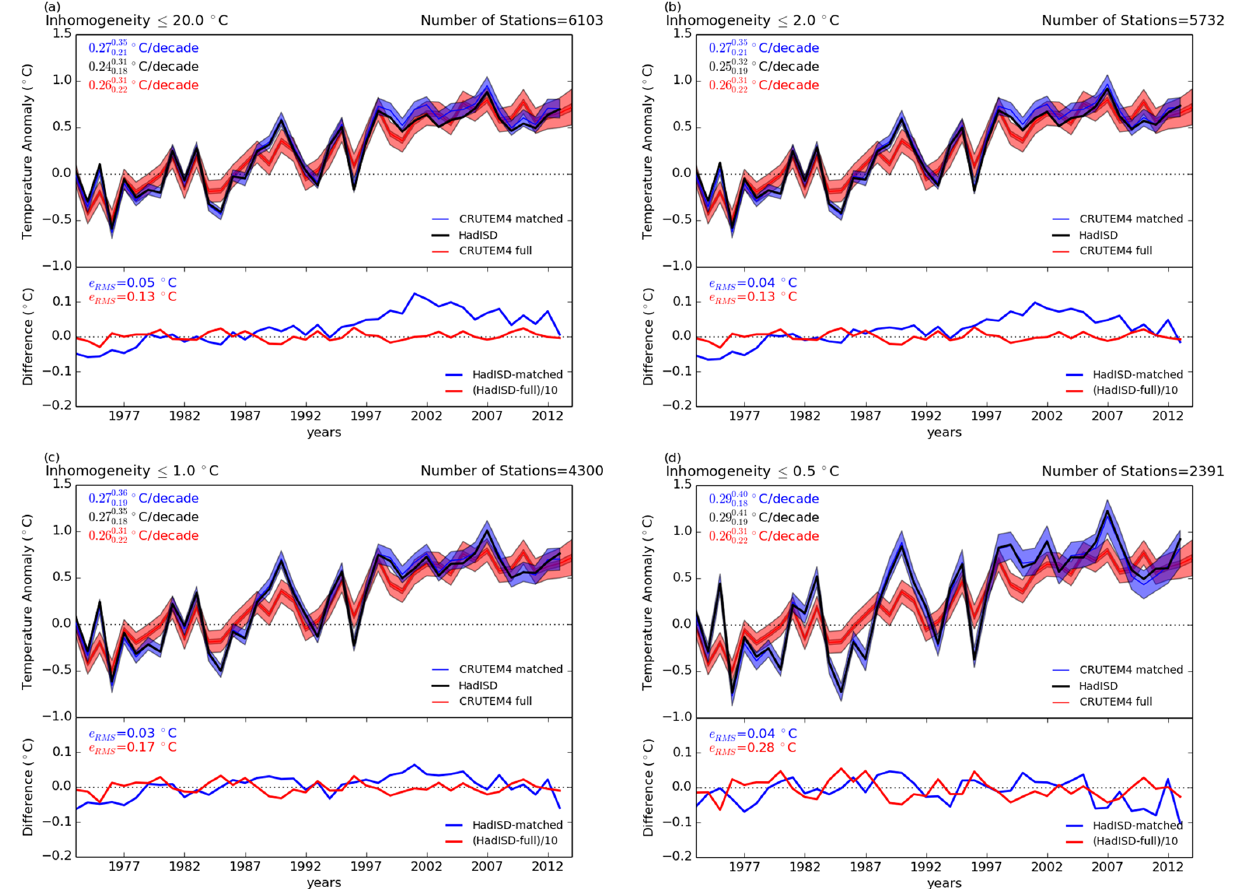
Figure 15. The CRUTEM4 global temperature series (red) compared with a CRUTEM4 series matched to the HadISD coverage (blue) and the global series as calculated from HadISD (black). The shading surrounding the matched CRUTEM4 (blue) shows the combined station, grid-box sampling and bias uncertainties. The dark shading for the full CRUTEM (red) shows the combined station and grid-box sampling uncertainties, with the light shading including the bias and coverage uncertainties as well. (a) No restrictions on the magnitudes of the inhomogeneities (all stations); (b) magnitudes < 2 ◦ C, (c) < 1 ◦ C and (d) < 0 . 5 ◦ C. The trends for each of the three curves are given in the top left of each panel, with the 5th- and 95th-percentile values shown in the sub- and superscripts, respectively, as calculated using the median of pairwise slopes algorithm. The bottom panels show the differences between HadISD and CRUTEM4 matched to the HadISD sample (blue) and HadISD and the full CRUTEM4 ( ÷ 10, red) along with the rms differences. In this plot there is no restriction on the number of change points allowed in a station